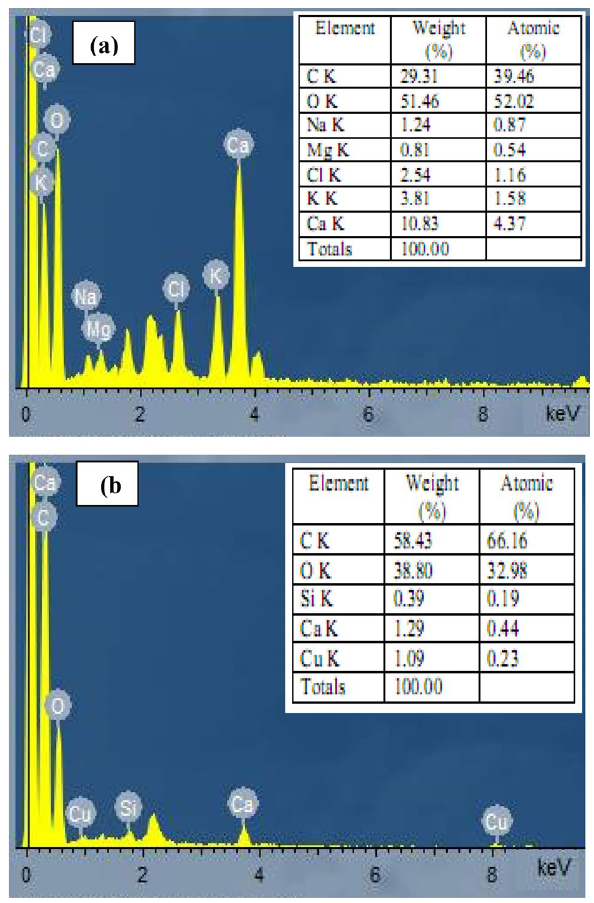
Figure 7. EDX images of R. damascena leaves ( a ) before and ( b ) after Cd 2+